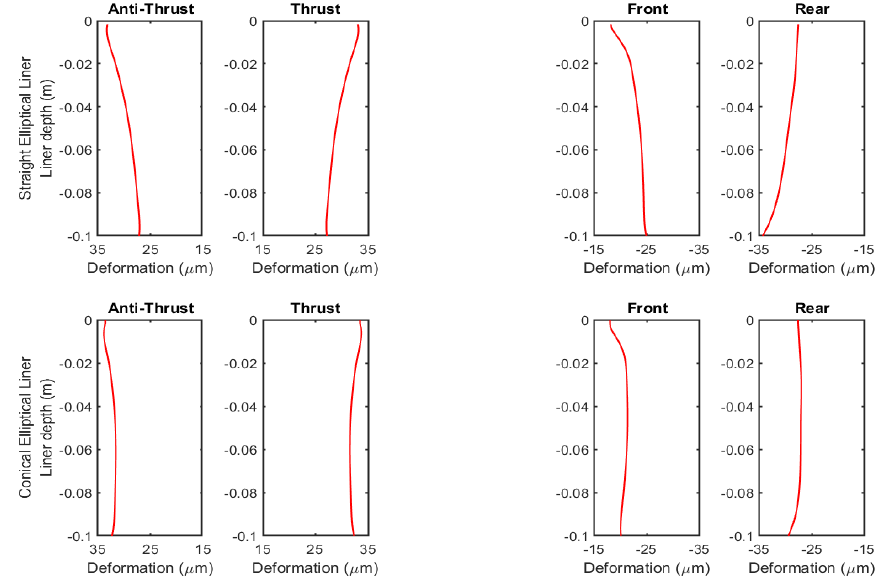
Figure 5. Bore deformation for straight ( top ) and conical elliptical liners ( bottom ) for the hot operation case.